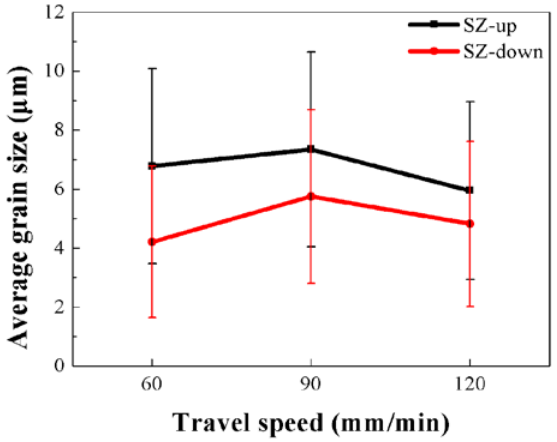
Figure 8. Effect of the travel speed on the average size of dynamic recrystallized (DRXed) grains in different SZ regions of the FSP Mg–6Sn–2Zn samples.